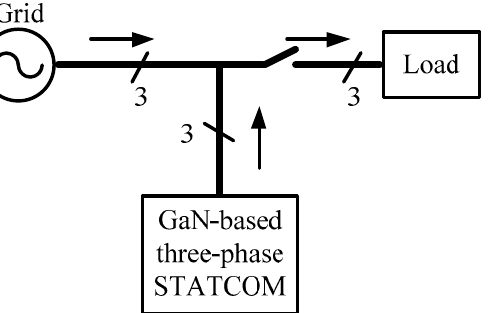
Figure 1. The test system architecture consisting of a grid, a load, and a GaN HEMTs-based three- phase STATCOM.